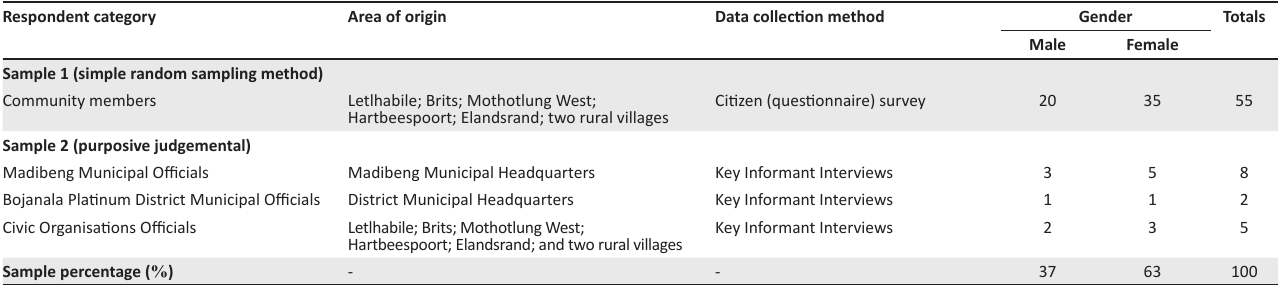
TABLE 1: Respondents’ profiles ( n =